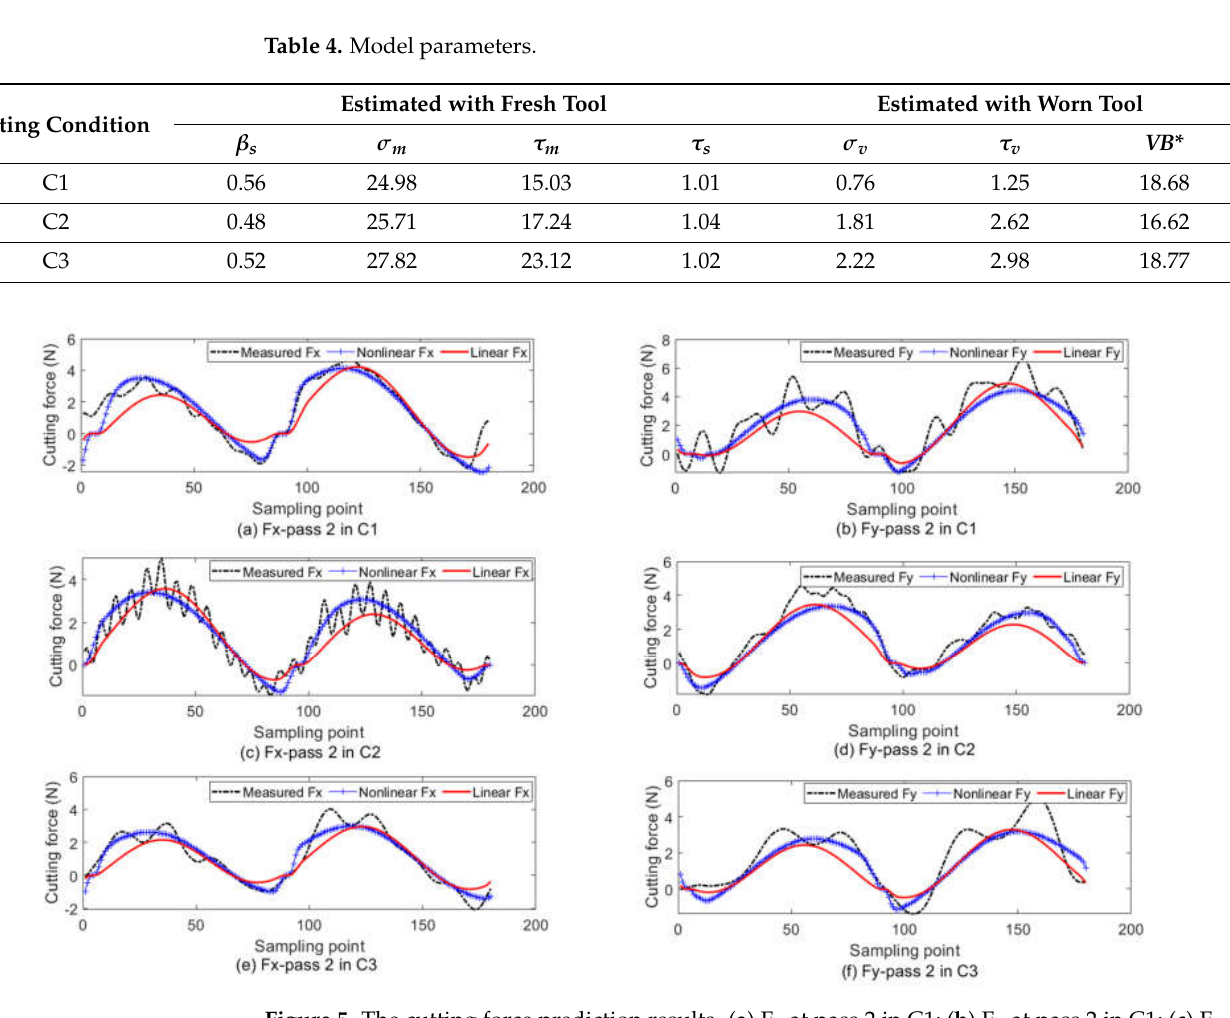
Figure 5. The cutting force prediction results. ( a )Fx at pass 2 in C1; ( b ) Fy at pass 2 in C1; ( c ) Fx at